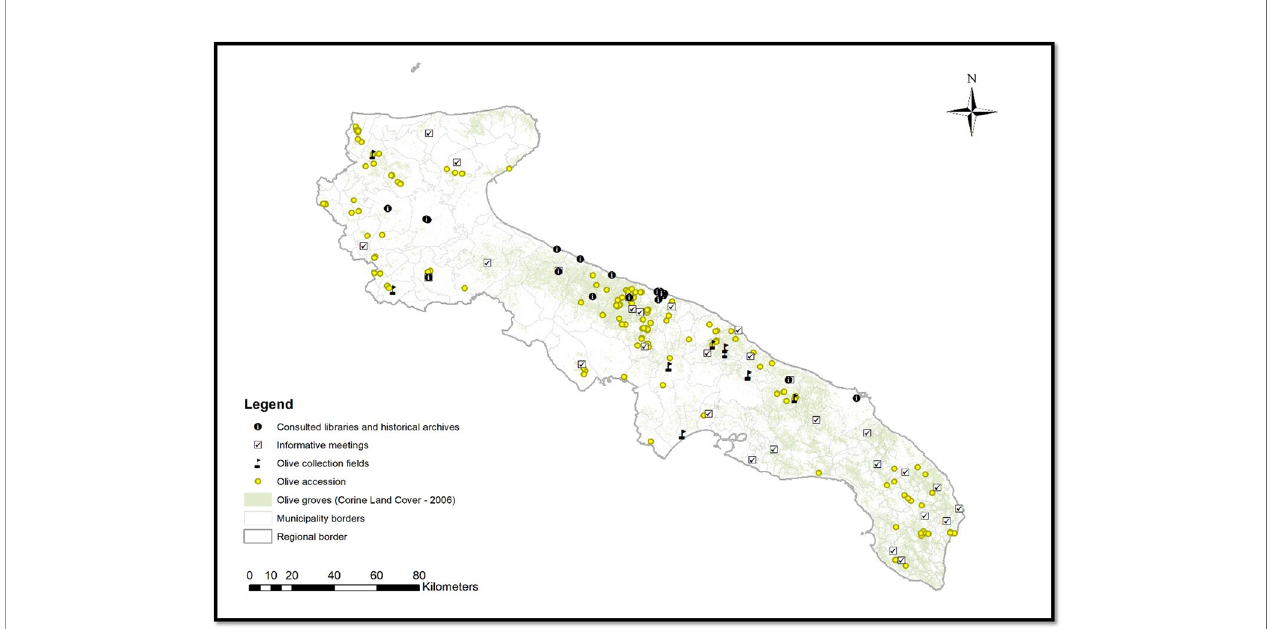
FIGURE 1 | Geographic map of ‘ Apulia ’ with collection sites of